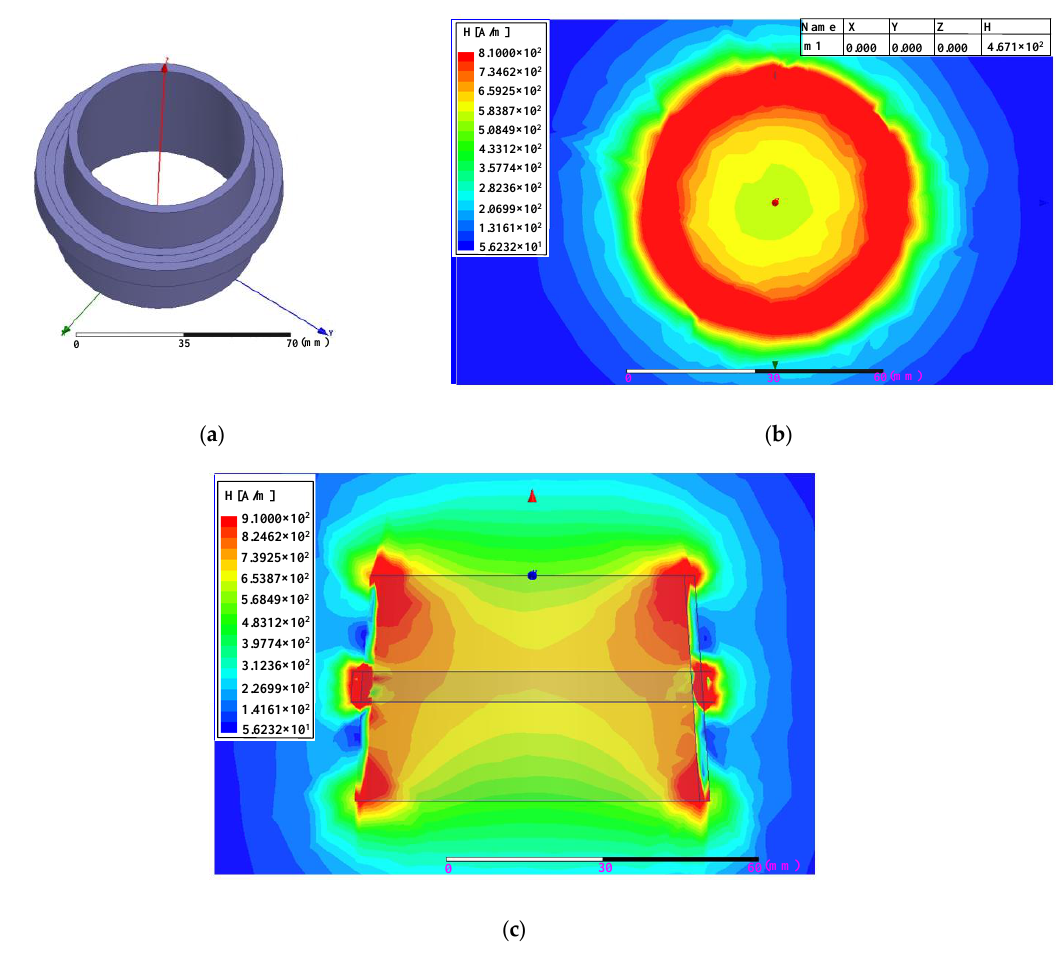
Figure 4. The two–four layer intermediate winding coil and simulated electromagnetic field: ( a ) structural diagram; ( b ) X–Y section of the magnetic field; and ( c ) X–Z section of the magnetic field.